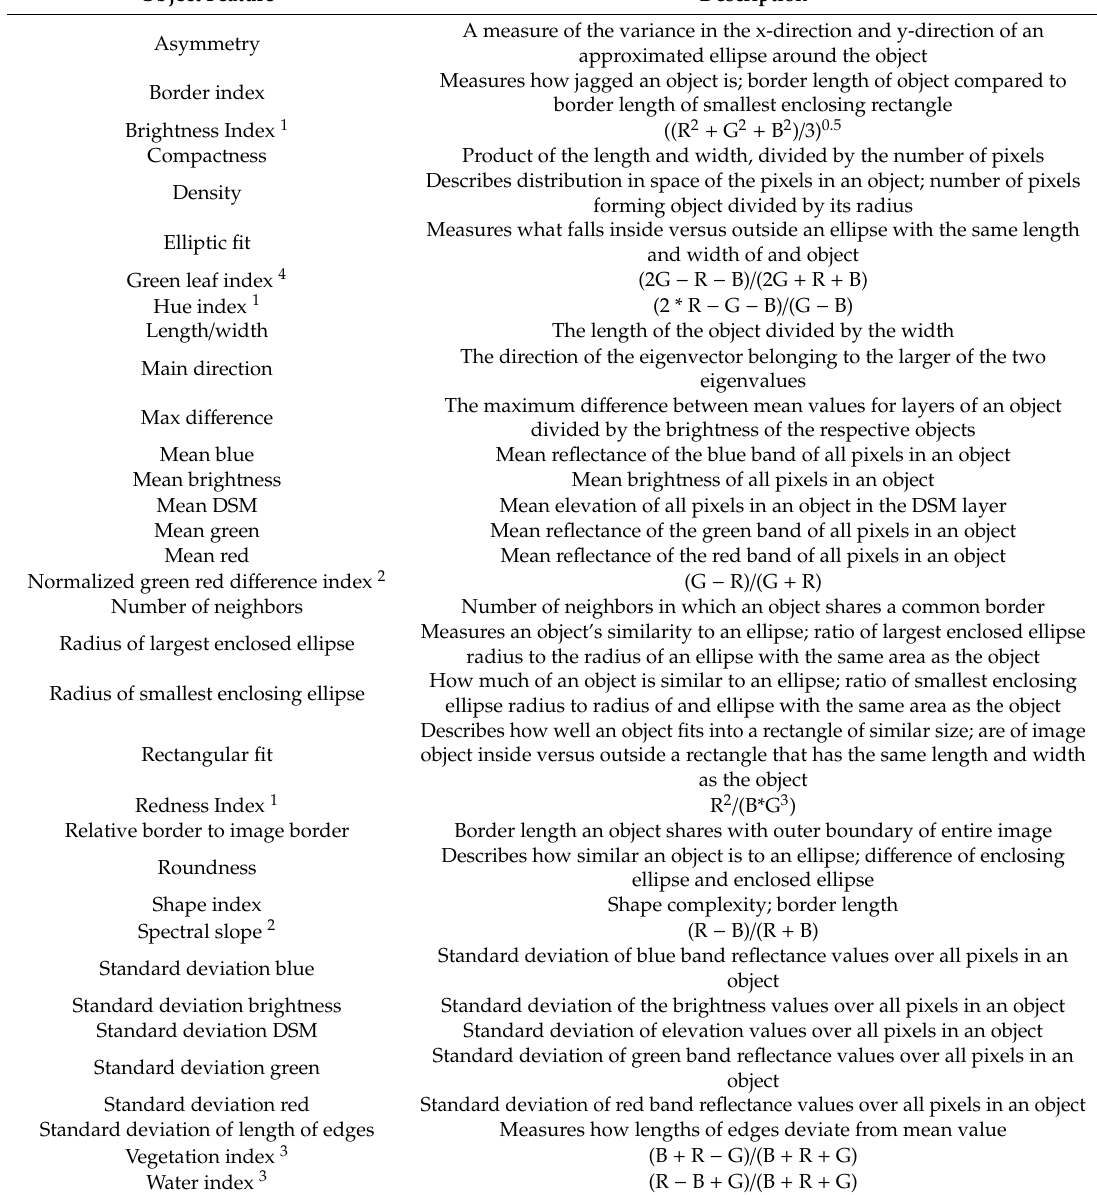
Table A1. Description of object features used in the feature-space optimization and their corresponding descriptions adapted from the eCognition reference book and Bialas